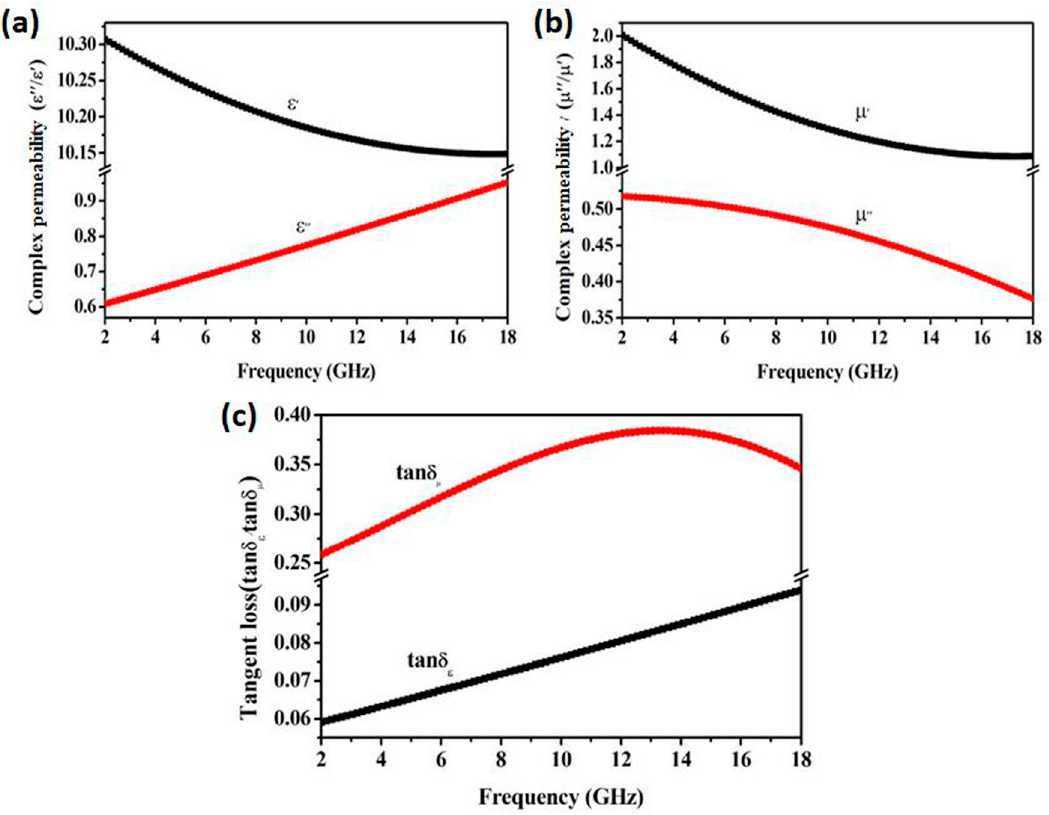
Figure 4. Dielectric constant ( a ), permeability ( b ) and loss factor ( c ) of FeCo single-phase solid solution sample.